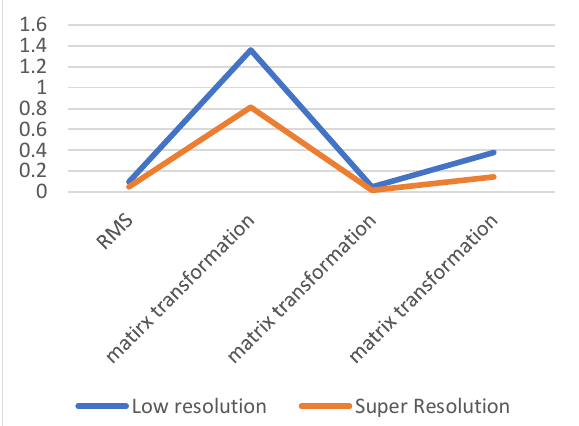
Figure 15: RMS [m] and matrix transformation both low and super resolution images for